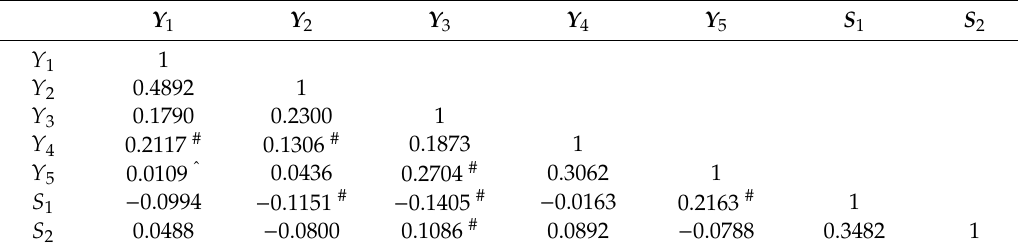
Table 9. Spearman’s Rank correlation matrix of the perturbed data using the GADP